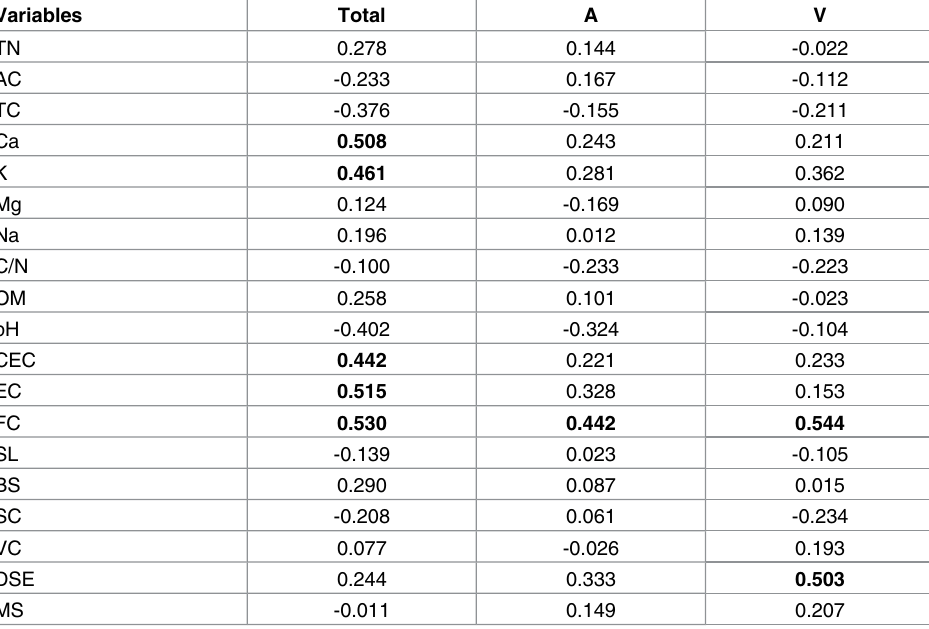
Table 3. Correlation between the Percentageof AMF Root Colonization, Soil Properties, Soil Morphol- ogy, Vegetation Coverage and DSE Colonization Calculated Using the Kendal